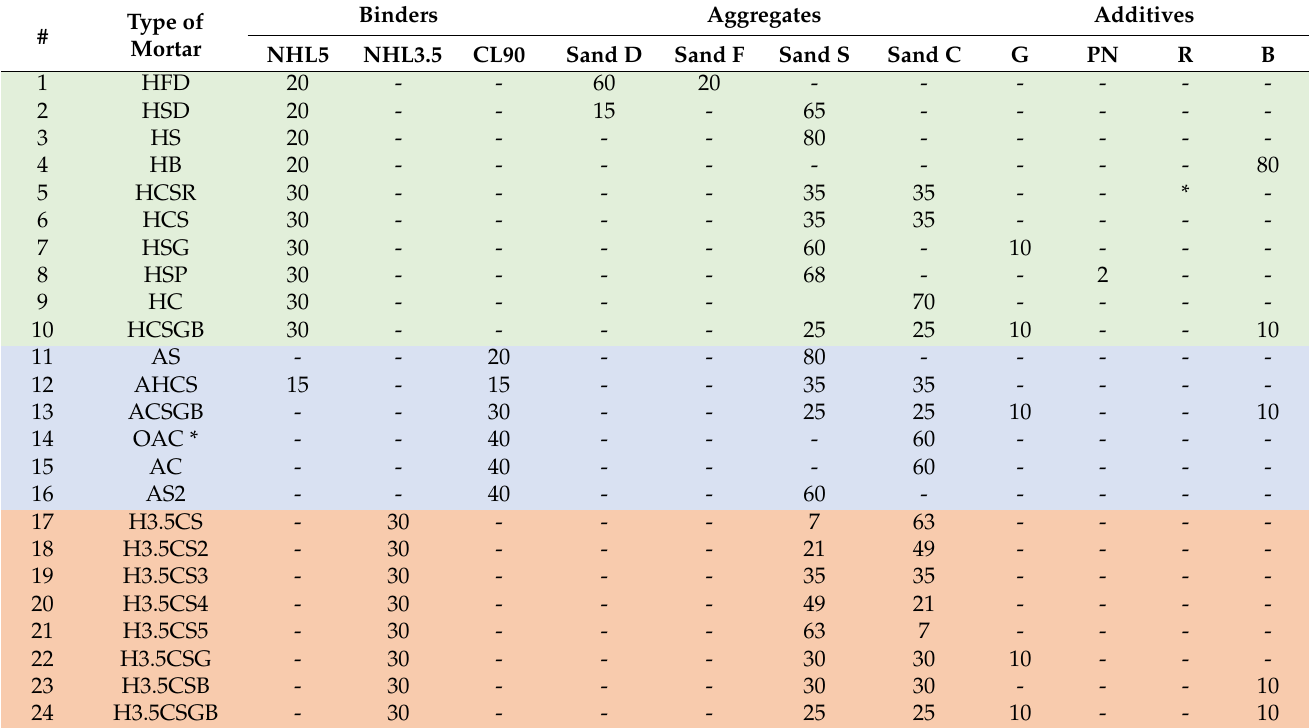
Table 1. Restoration mortar formulations ( ± 1% w / w ). G: Ground waste glass, PN: Pinecone, R (pinecone resin solution indicated as *), B: Ground brick waste grounded, Sand: S (Sacamat), C (BPE Leciuex), D (Italcementi group) and F